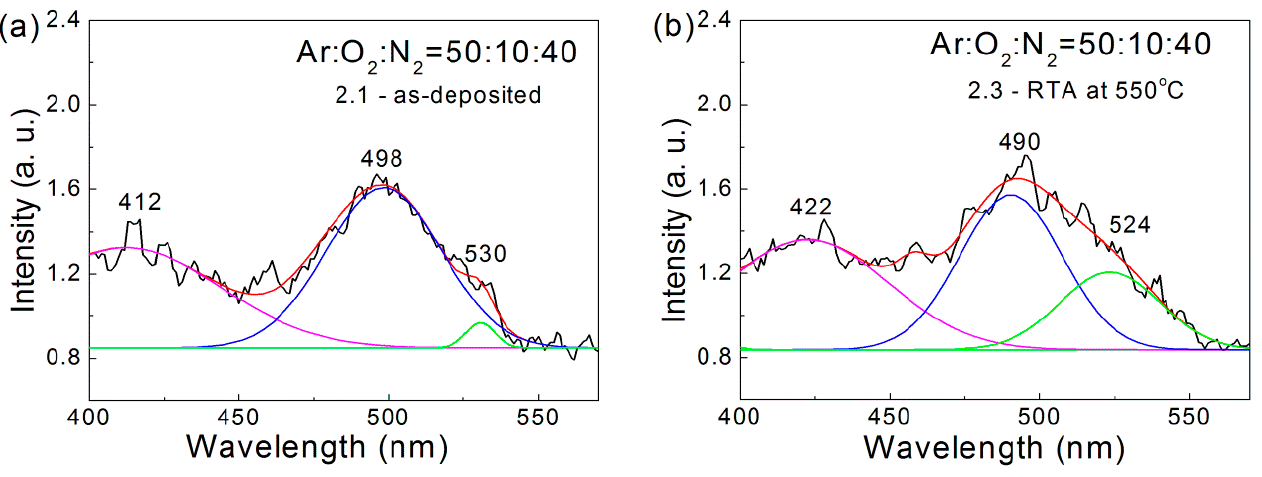
Figure 2. Representative PL spectra of the ZnO:N films deposited in a gas mixture of Ar:O 2 :N 2 = 50:10:40: ( a ) as-deposited (sample 2.1) and ( b ) after RTA at 550 °C (sample 2.3).